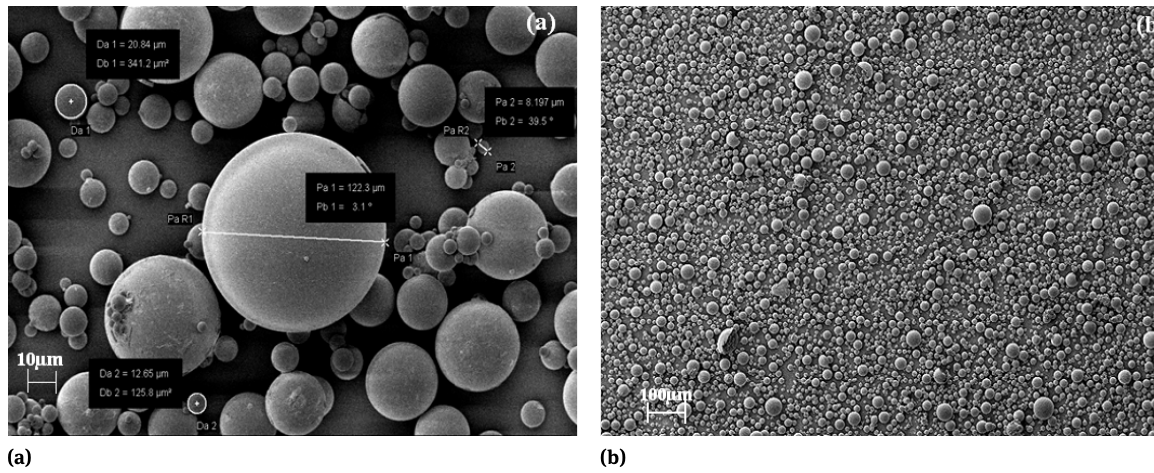
Figure 1: Microstructure of Hollow Glass Microsphere: (a) and (b) are Scanning Electron Microscopy (SEM) images showing different magnifi- cation of HGM at 10 µ m and 100 µ m